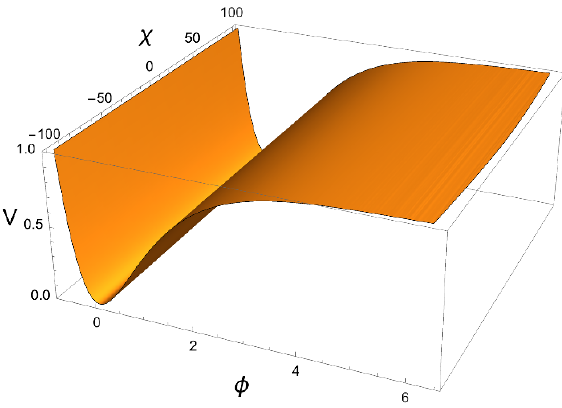
Figure 3 . The scalar potential for (cid:30) and (cid:31) with for (cid:12)eld ranges di(cid:11)erent from that of (cid:12)gure